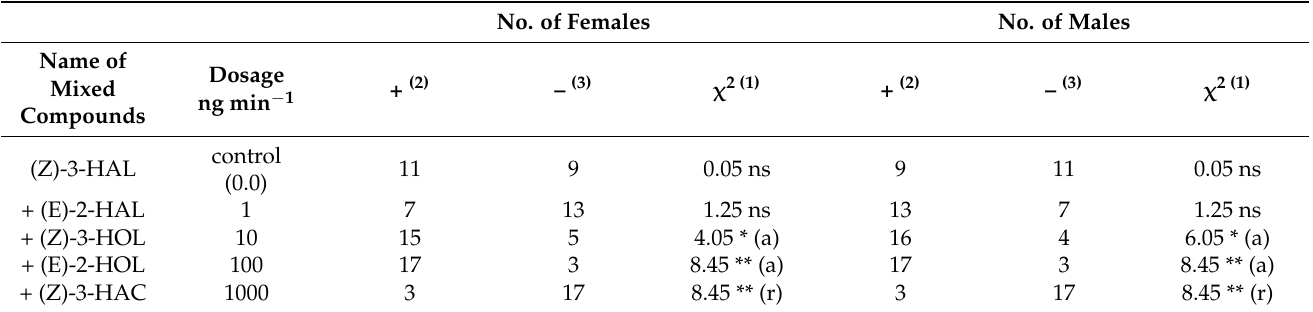
Table 4. The effect of a synthetic blend of five plant GLVs that are induced by DJA on the number of A. miniatum adult females and males choosing to enter a Y-tube arm containing the blend odor or the control Y-tube arm with no odor containing purified, humidified air and hexane solvent. No. of Females No. of